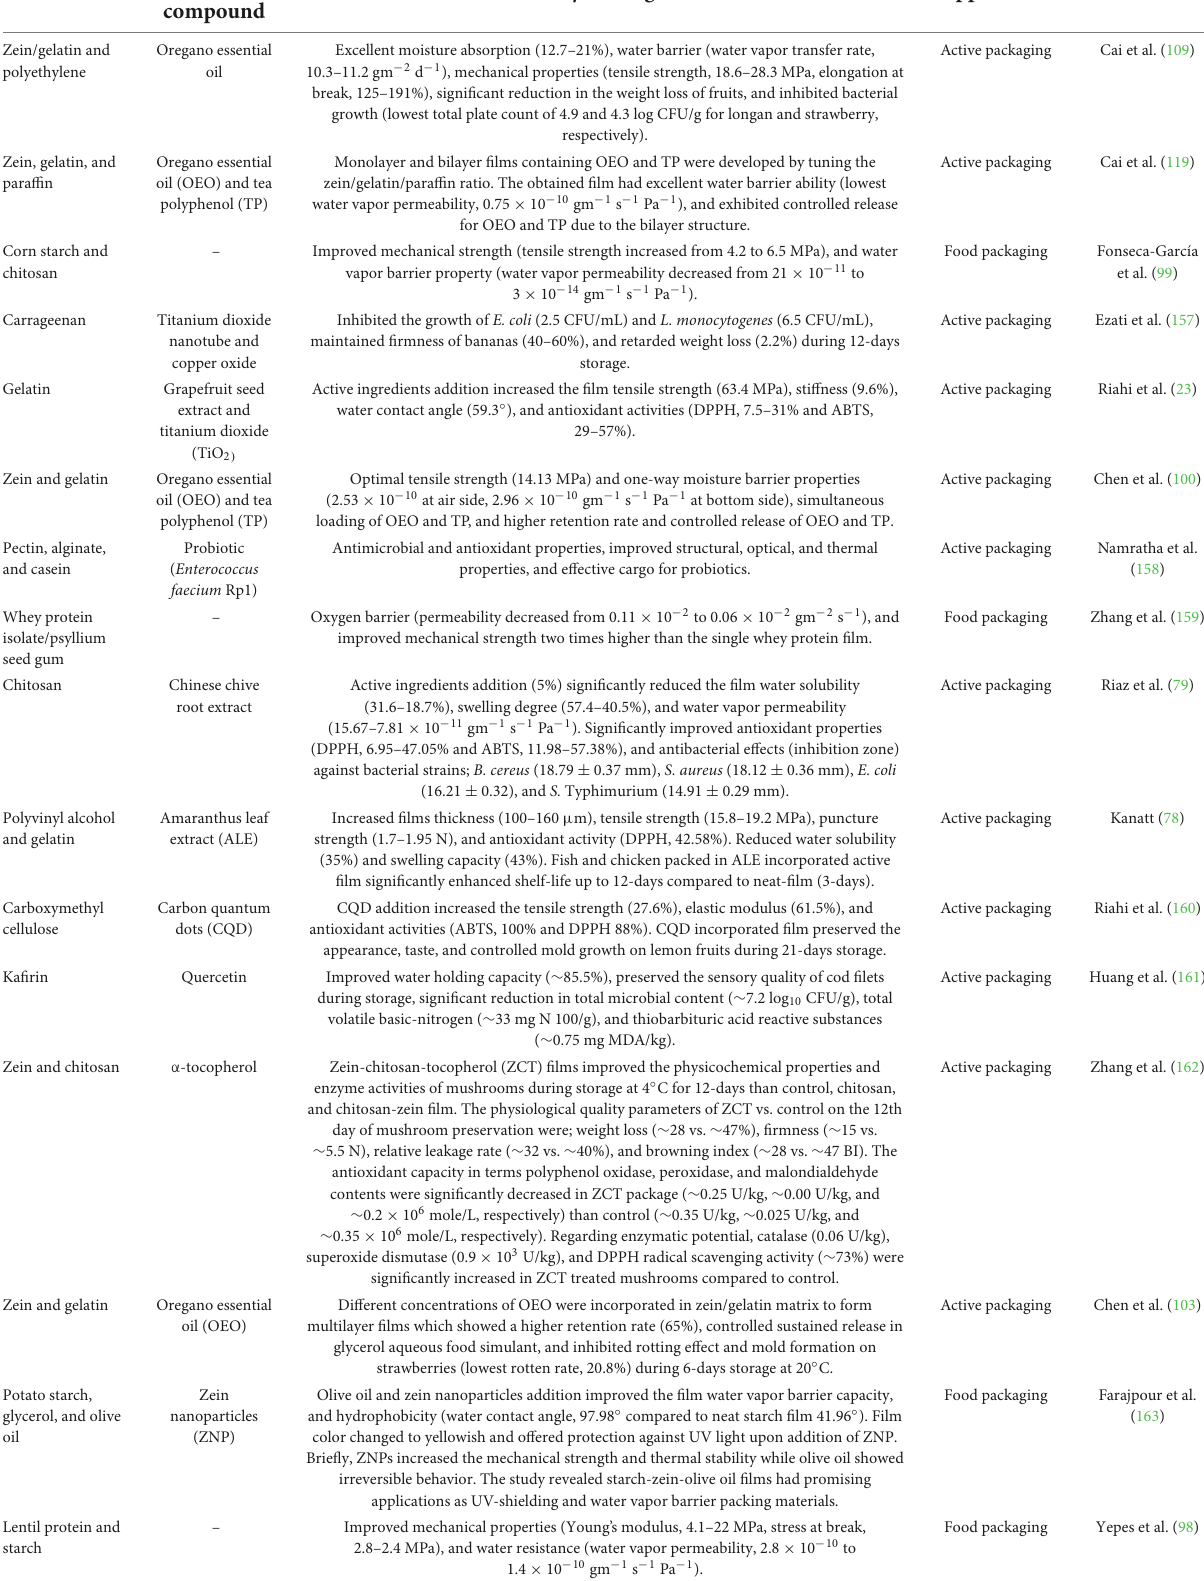
TABLE 1 Biopolymer-based functional films for active packaging